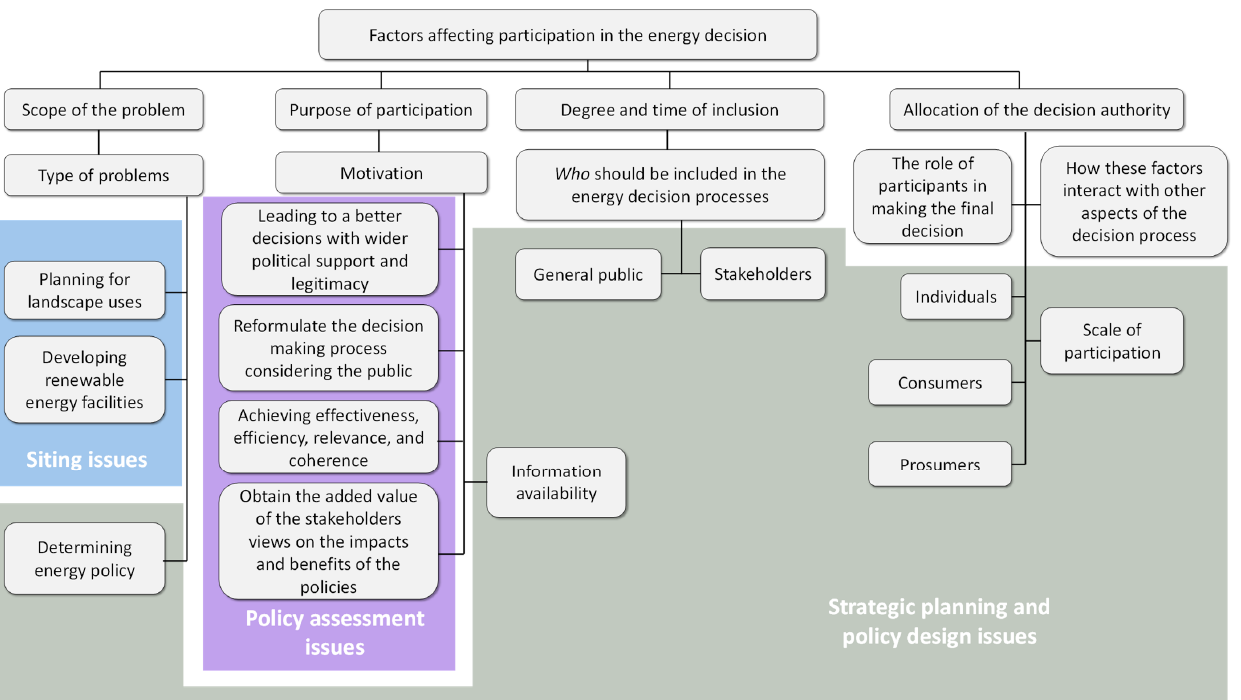
Figure 1. Concepts and factors affecting participation in energy decision based on Bidwell [22] and enriched by the au-